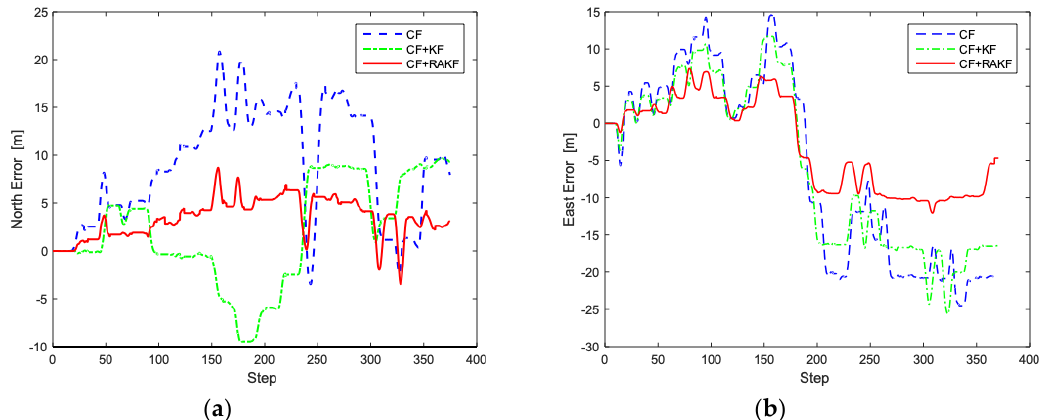
Figure 12. Comparison of trajectory in running under different heading estimation algorithms performed in second floor of IOT Engineering College.